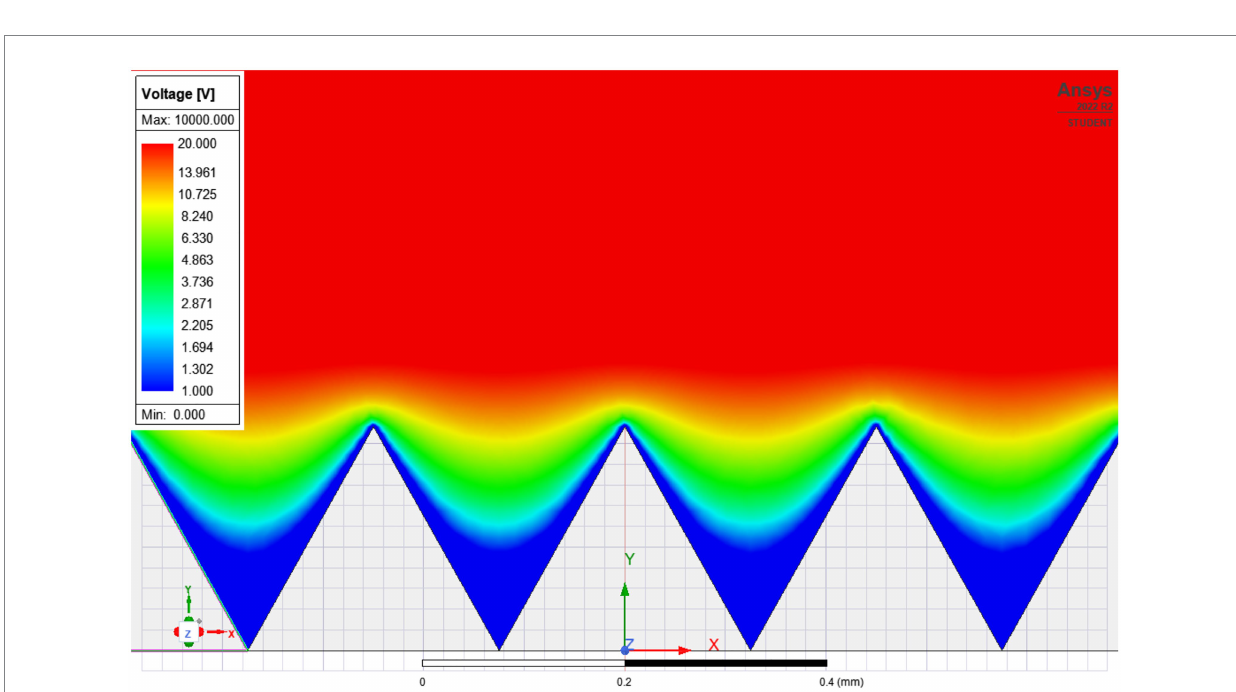
FIGURE 11 FEM-simulation of the electric potential over the triangular surface structure. Since the differences in the electrical potential are vanishingly small compared to the total voltage, the scale has been truncated at 20 V, since otherwise no differences in the color plot would be visible. For the typical distances in practical electrospinning, the local field distortions due to the surface structures can be neglected compared to other effects such as viscous drag or turbulent air flow.